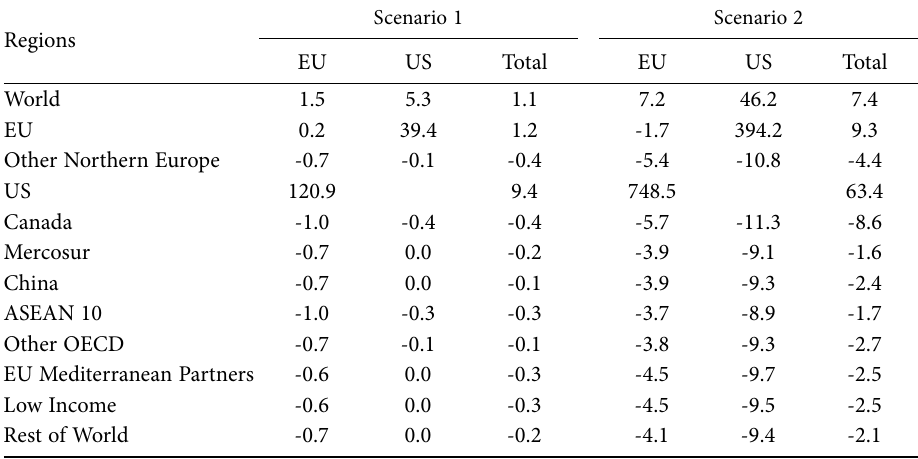
Table 3. Export volumes by region for “processed food” [%